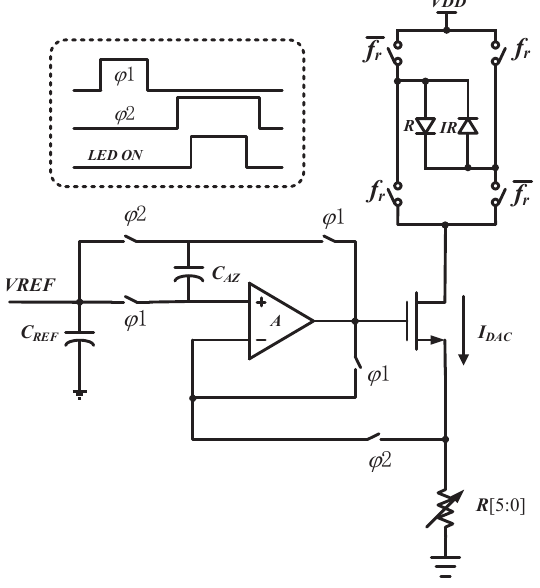
Figure 9. Circuit implementation of TX.